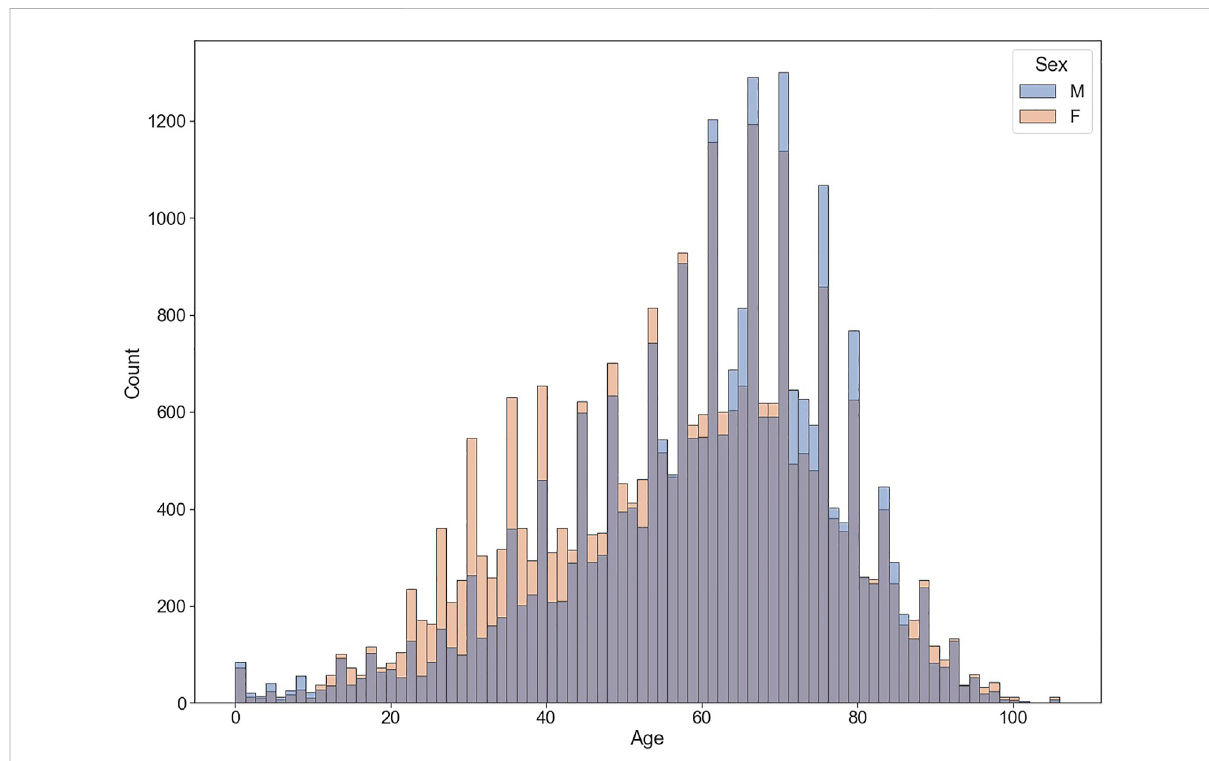
FIGURE 2 Age – sex distribution of COVID-19 associated